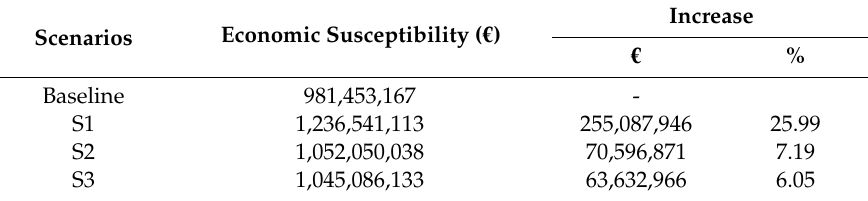
Table 9. Economic susceptibility di ff erences according to the baseline period, S1, S2 and S3